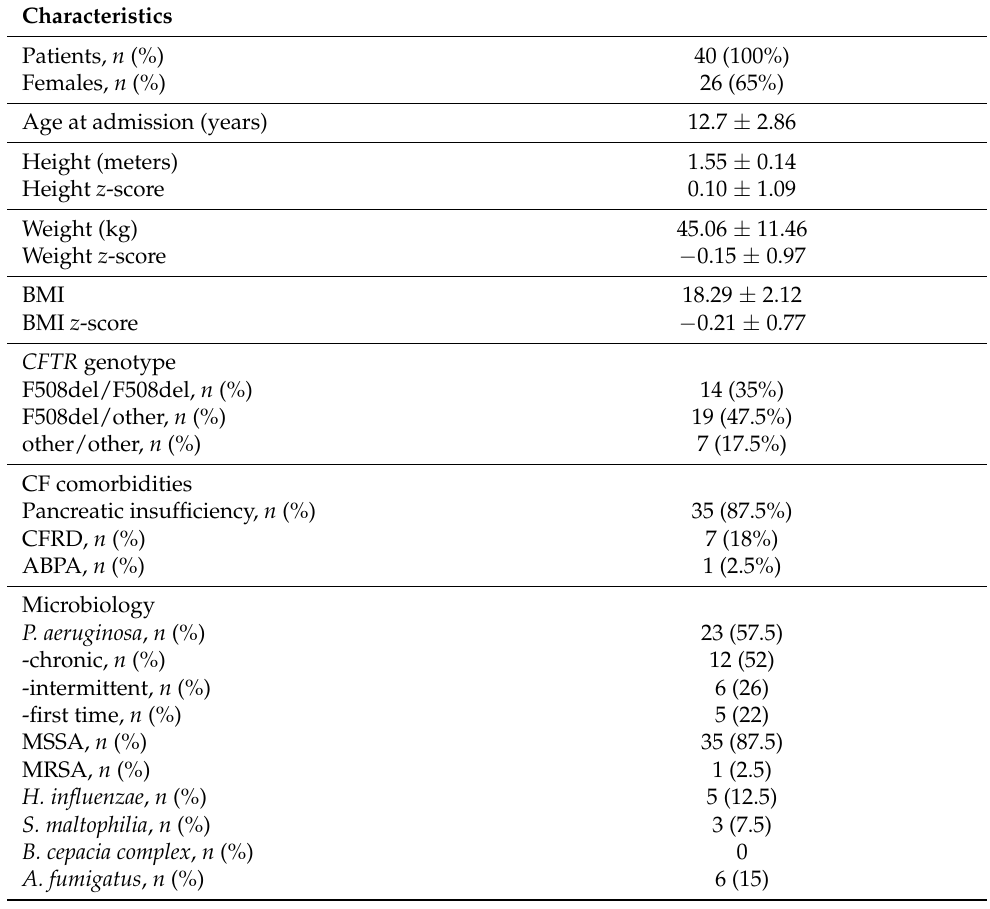
Table 1. Characteristics of the study population and its microbiological status (BMI = body mass index, CFRD = cystic fibrosis-related diabetes, ABPA = allergic bronchopulmonary